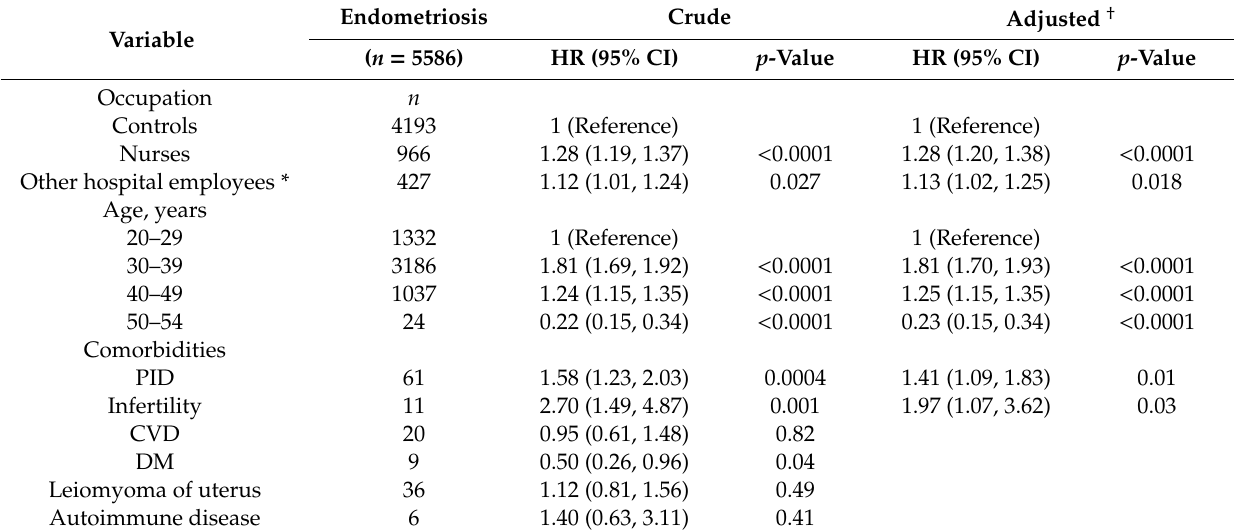
Table 2. Endometriosis cases by study cohort, age, and comorbidity and Cox method estimated hazard ratios of endometriosis.